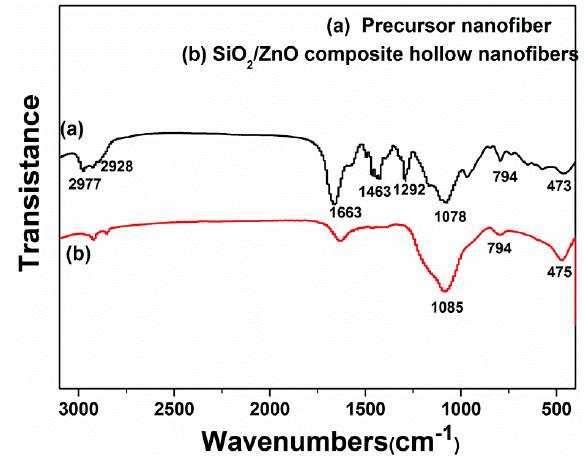
Figure 3. Fourier transform infrared spectroscopy (FT-IR) spectra of ( a ) the precursor sub-micron fibers and ( b ) SiO 2 /ZnO composite hollow sub-micron fiberscalcined at 550 °C.